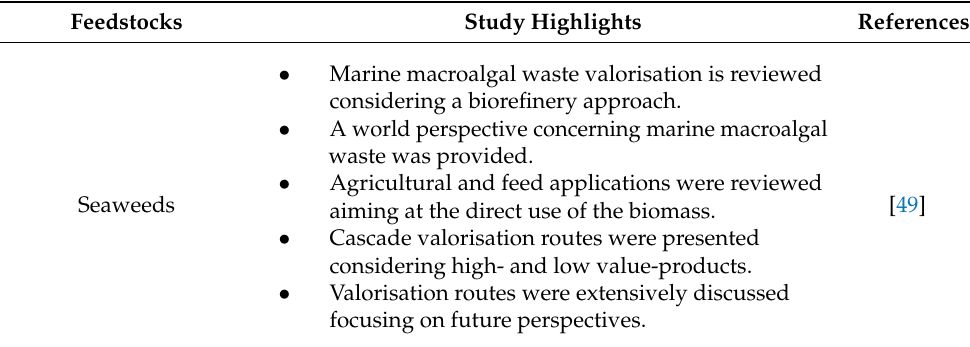
Table 1. Key points of some previous published papers on marine resources for biorefinery, compared to current review